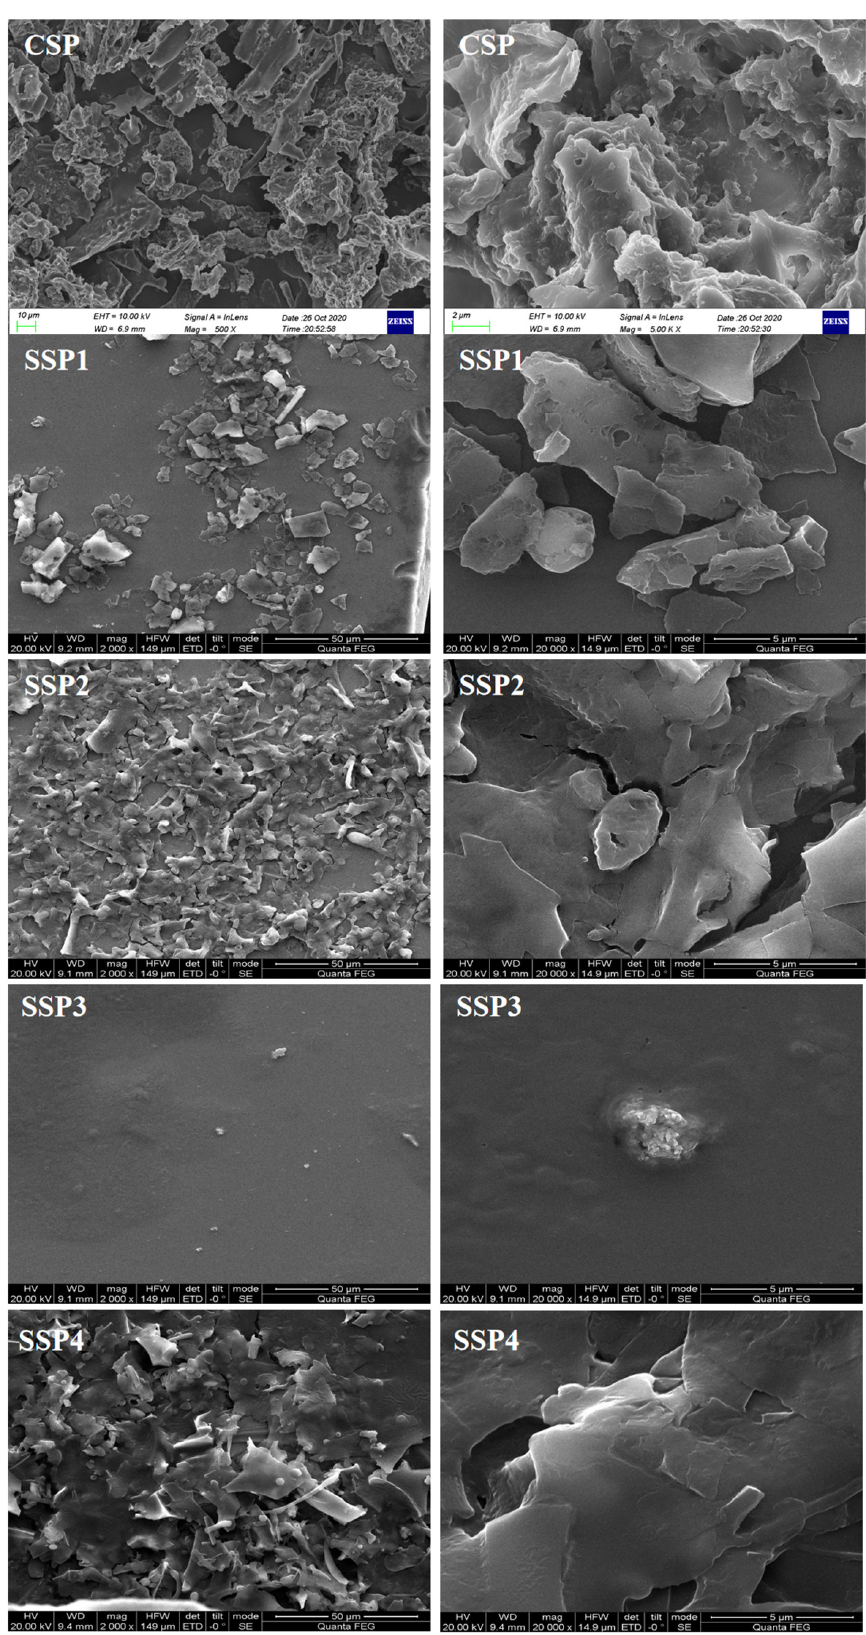
Figure 6. The scanning electron microscopy of CSP and SSPs.